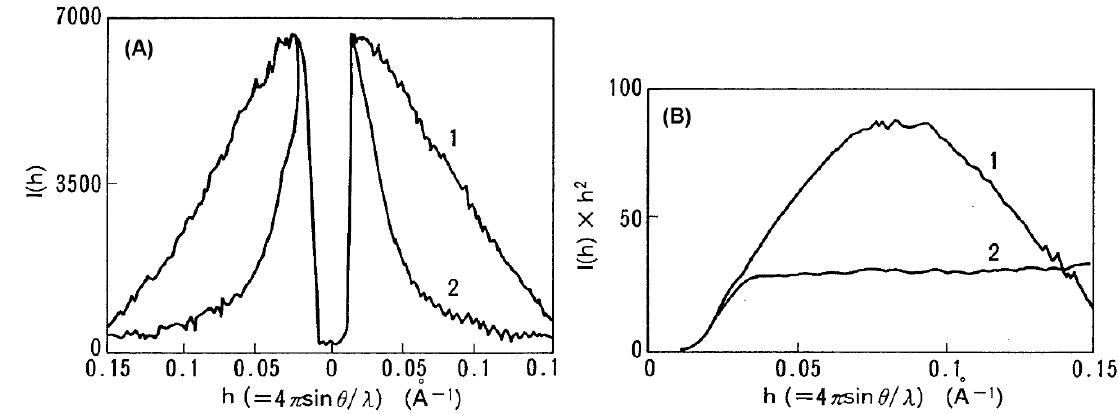
Figure 1. Synchrotron small-angle X-ray scattering (SAXS) patterns ( A ) and Kratky plots ( B ) for bovine carbonic anhydrase (1) in the N state (0.05 M Tris-HCl (pH 8)) and (2) in the U state (0.05 M Tris-HCl (pH 8), 8.5 M urea). Reproduced with permission from [28].